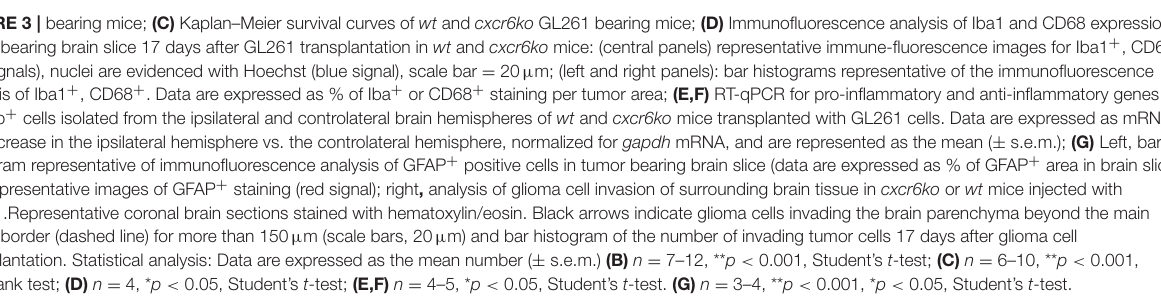
FIGURE 3 | bearing mice; (C) Kaplan–Meier survival curves of wt and cxcr6ko GL261 bearing mice; (D) Immunofluorescence analysis of Iba1 and CD68 expression in tumor bearing brain slice 17 days after GL261 transplantation in wt and cxcr6ko mice: (central panels) representative immune-fluorescence images for Iba1 + , CD68 + (red signals), nuclei are evidenced with Hoechst (blue signal), scale bar = 20 µ m; (left and right panels): bar histograms representative of the immunofluorescence analysis of Iba1 + , CD68 + . Data are expressed as % of Iba + or CD68 + staining per tumor area; (E,F) RT-qPCR for pro-inflammatory and anti-inflammatory genes in CD11b + cells isolated from the ipsilateral and controlateral brain hemispheres of wt and cxcr6ko mice transplanted with GL261 cells. Data are expressed as mRNA fold increase in the ipsilateral hemisphere vs. the controlateral hemisphere, normalized for gapdh mRNA, and are represented as the mean ( ± s.e.m.); (G) Left, bar histogram representative of immunofluorescence analysis of GFAP + positive cells in tumor bearing brain slice (data are expressed as % of GFAP + area in brain slice), and representative images of GFAP + staining (red signal); right , analysis of glioma cell invasion of surrounding brain tissue in cxcr6ko or wt mice injected with GL261.Representative coronal brain sections stained with hematoxylin/eosin. Black arrows indicate glioma cells invading the brain parenchyma beyond the main tumor border (dashed line) for more than 150 µ m (scale bars, 20 µ m) and bar histogram of the number of invading tumor cells 17 days after glioma cell transplantation. Statistical analysis: Data are expressed as the mean number ( ± s.e.m.) (B) n = 7–12, ** p < 0.001, Student’s t -test; (C) n = 6–10, ** p < 0.001, long-rank test; (D) n = 4, * p < 0.05, Student’s t -test; (E,F) n = 4–5, * p < 0.05, Student’s t -test. (G) n = 3–4, ** p < 0.001, * p < 0.05, Student’s t